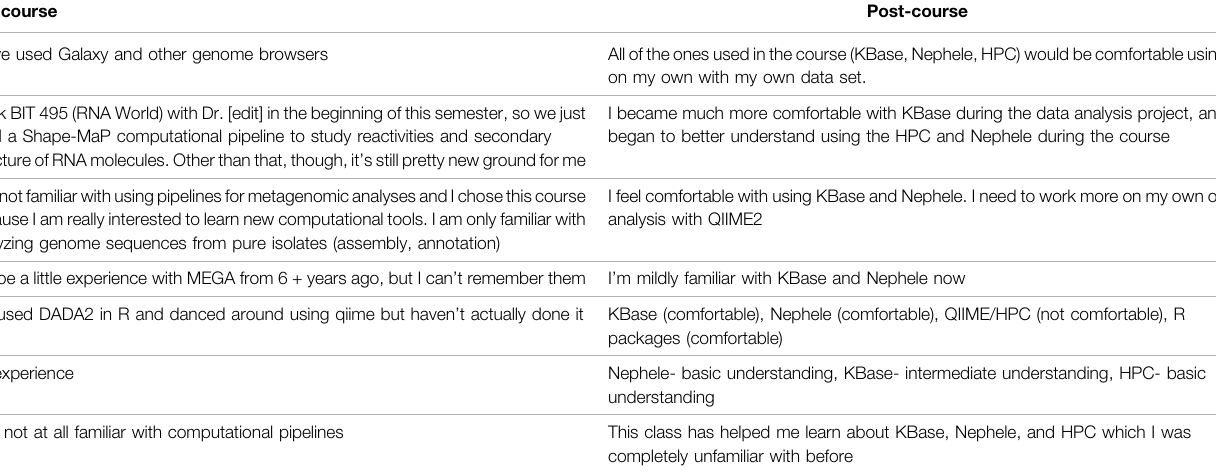
TABLE 3 | Select student responses to the question “ List and describe your familiarity with computational pipelines for metagenomic analyses. ”